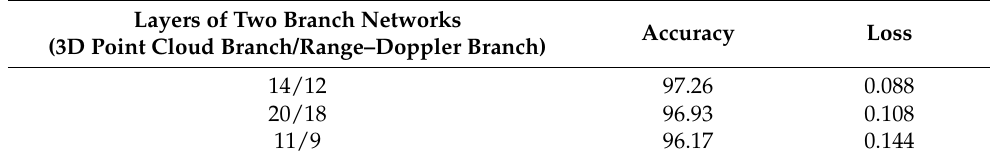
Table 5. Accuracy and loss of fusion network of three different depth. Layers of Two Branch